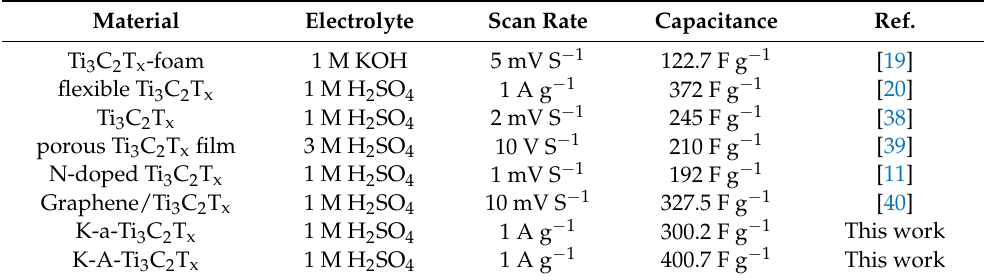
Table 1. Comparison of capacitance for the Ti 3 C 2 T x -based electrodes